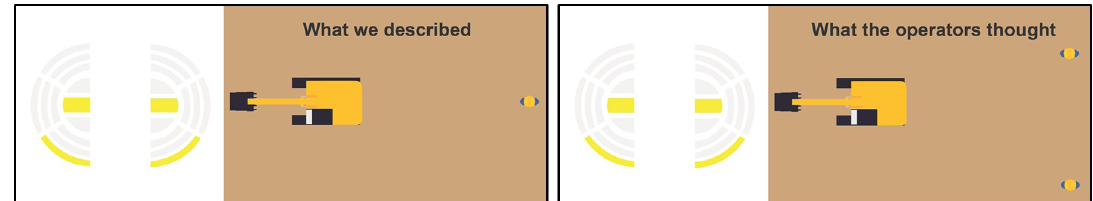
Figure 14. These images illustrate the different ways of thinking between the designers who created the concept and the operators who used the concept. As illustrated in the left image, We previously described that when the same segments on both sides are turned on, then it means the obstacle is exactly in the front of or behind the machine. As shown in the right image, the operators thought that this visualization means that there are two obstacles behind the machine.